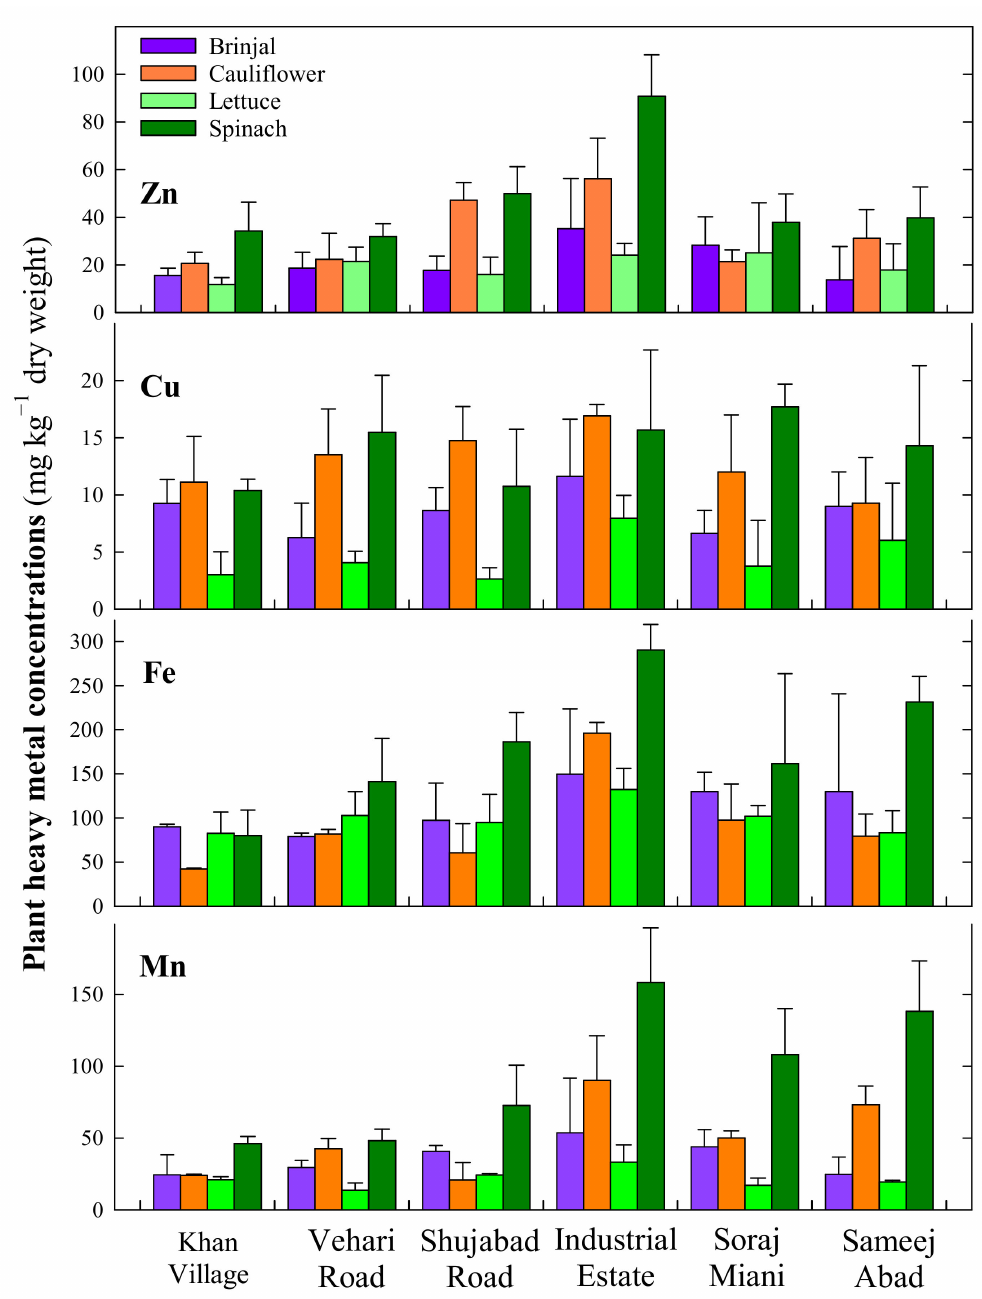
Figure 1. Zn, Cu, Fe, and Mn concentrations (mg kg − 1 dry weight) in brinjal ( Solanum melogena ) and spinach ( Spinacia oleacea ) harvested in April 2016, and lettuce ( Lactuca sativa L.) and cauliflower ( Brassica oleracea ) harvested in December 2015 from the Khan Village, Vehari road, Shujabad road, Industrial estate, Soraj miani, and Sameej abad study